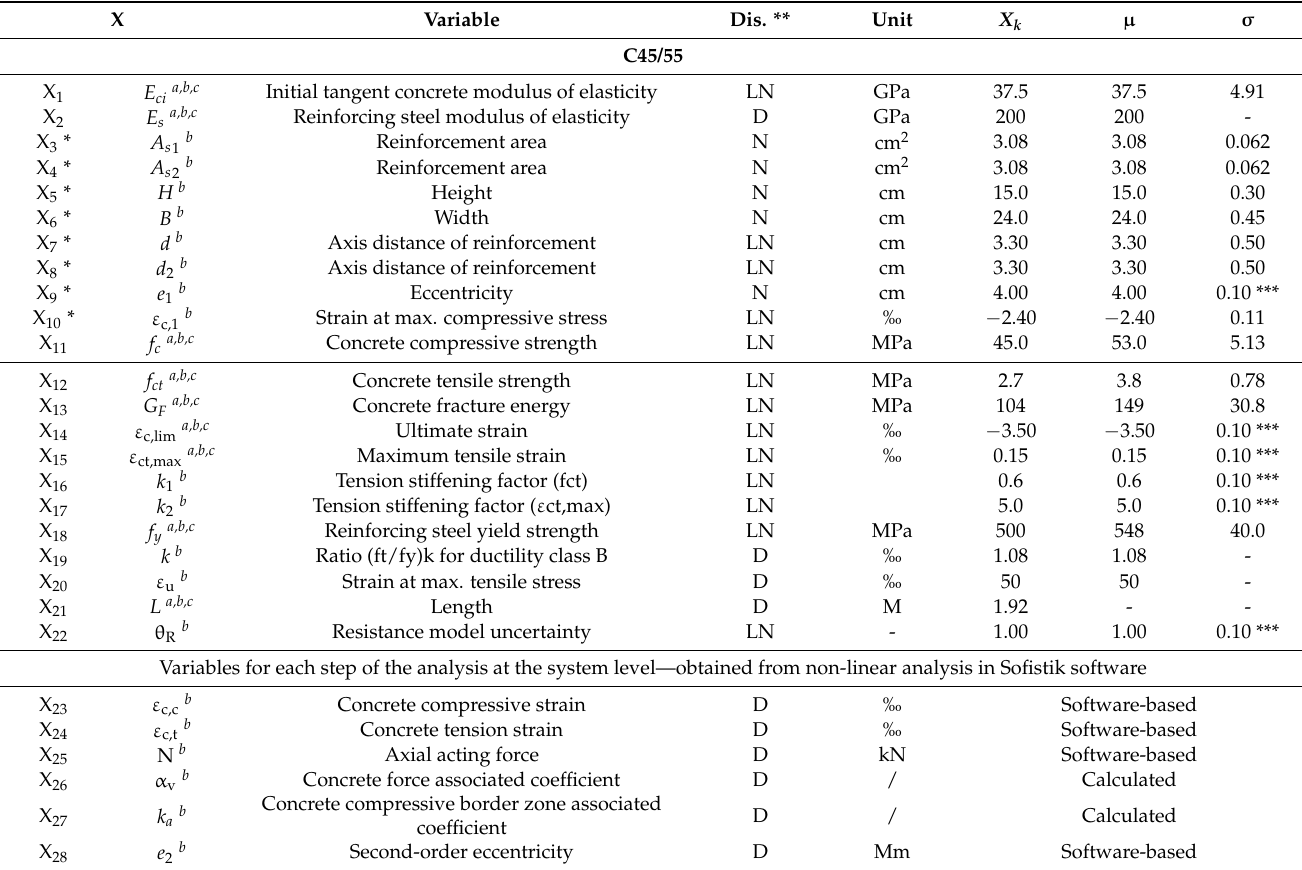
Table 3. Input parameters for the probabilistic analyses of the EN 1992-1-1 closed formulations provisions and the EN 1992-1 Non-Linear Finite Element provisions of the slender column made of